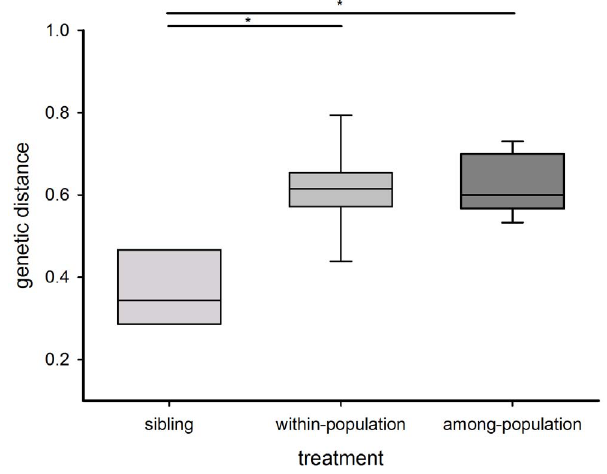
Figure 2. Genetic distance (POSA) of the three mating treatments (sibling, within-population and among-population pairs) measured as individual proportion of shared alleles. Box plots show the quartiles (box limits), the 10 th and 90 th percentiles (error bars) and the median (line). Statistically significant differences are indicated